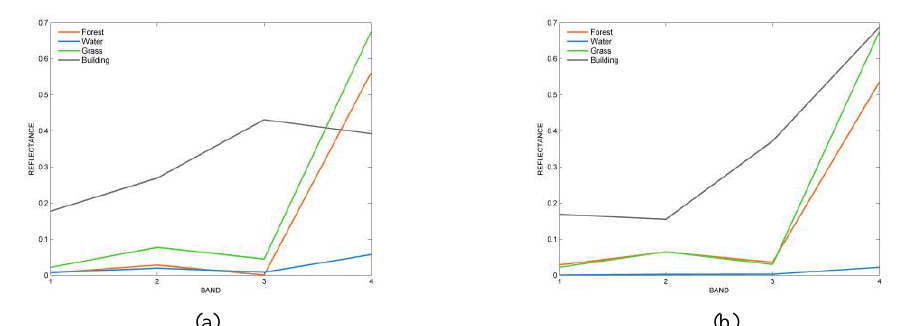
Fig.3.2the reflectance of four land cover type after topographic correction with HJ(a) and GF(b)